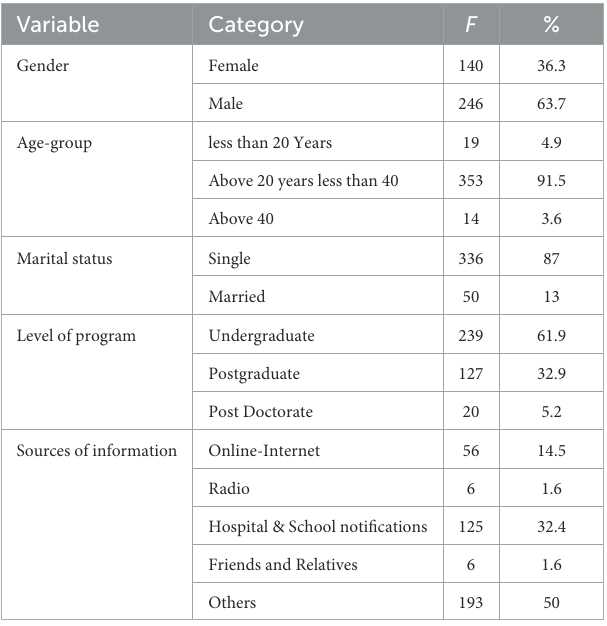
TABLE 1 Social demographic characteristics of the respondents ( N =